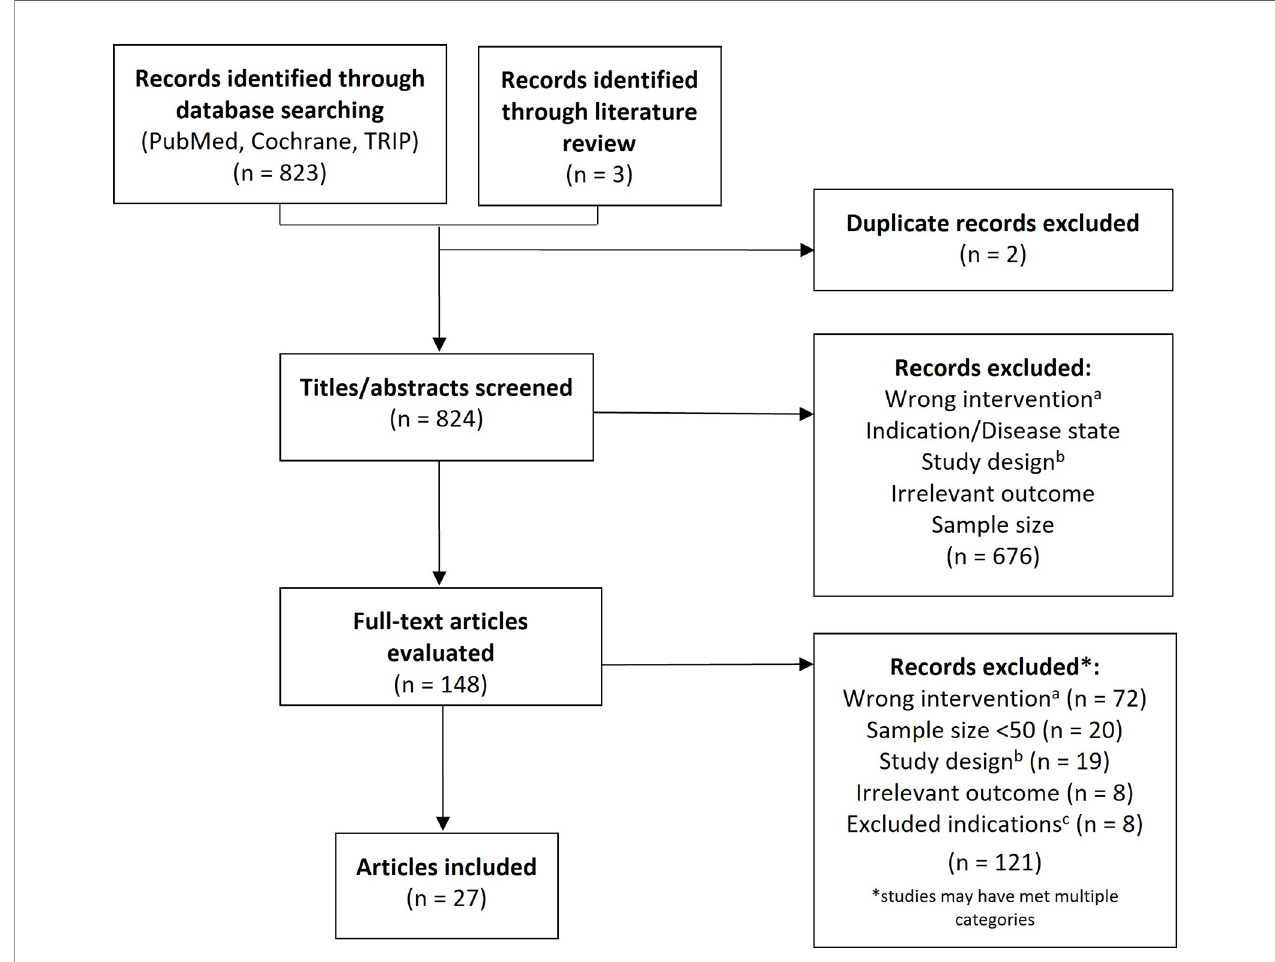
FIGURE 2 | PRISMA fl ow diagram. PRISMA fl ow diagram. a Intervention not sargramostim (e.g., molgramostim) and/or not administered via intravenous or subcutaneous route; b Exclusions comprised phase 1 trials and those that were not prospective, interventional, or observational studies (e.g., letter to the editor, retrospective studies, etc.); c Excluded studies were those assessing sargramostim for mobilization, as an adjuvant to vaccines or GM-CSF – expressing vaccines and studies supporting current FDA-approved